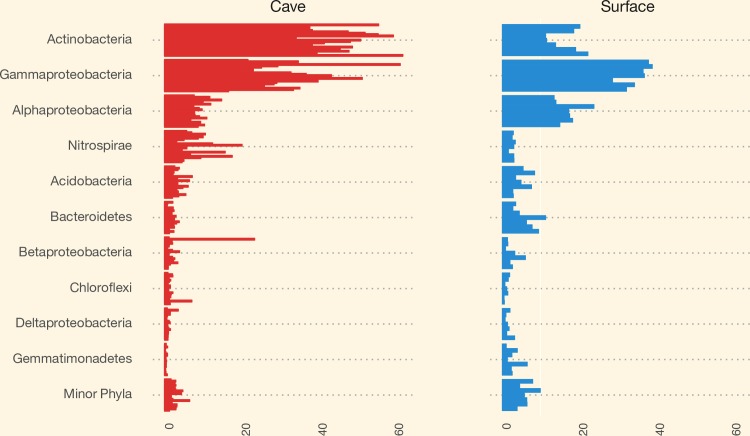
Staggered bar chart of relative abundance of OTUs.Major and minor phyla by all cave samples and all surface samples. Cave samples have a greater relative abundance of Actinobacteria and Nitrospirae.